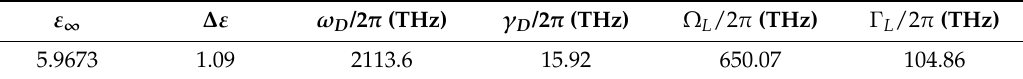
Table 1. Detailed parameters in the Drude–Lorentz (DL) model.